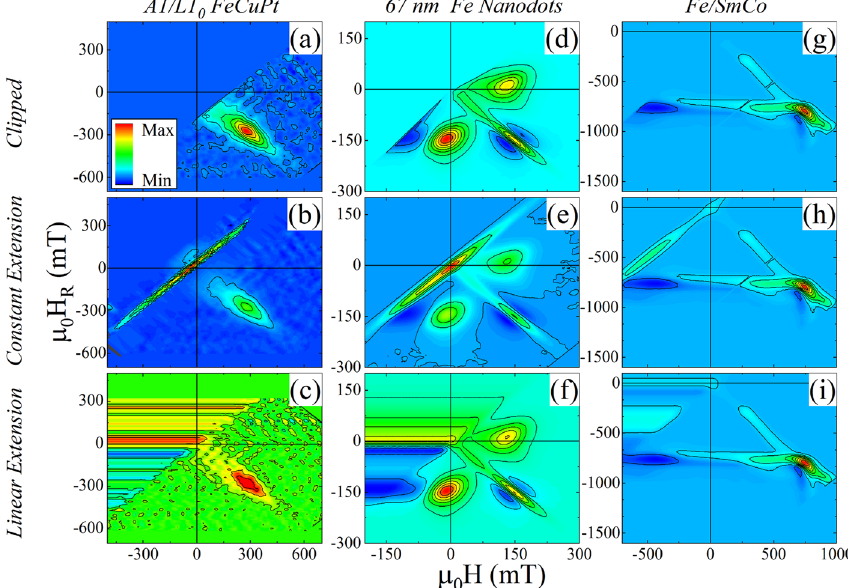
Figure 3. FORC distributions of ( a – c ) FeCuPt annealed at 350 °C, ( d – f ) 67 nm Fe nanodots, and ( g – i ) Fe/ SmCo exchange-spring